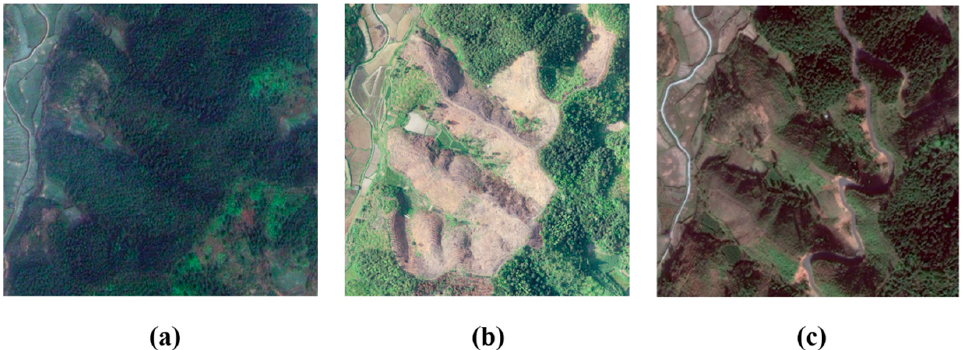
Figure 12. Rapid land-use changes in the same area. ( a ) Fir plantation (2009) ( b ) Barren land (2019) ( c ) Camellia plantation (2020).